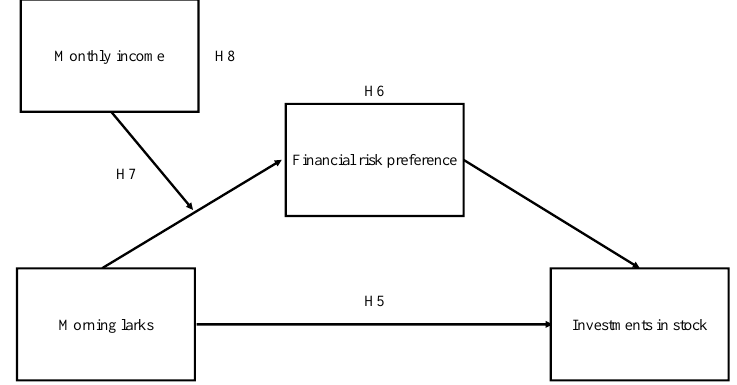
Figure 2. Illustrates the conceptual model for the relationships among morning-types, financial risk preference, and investments in stock. The direction of the arrows indicates the hypothesized effect.